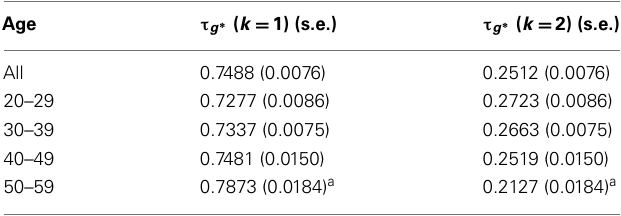
Table 3 | Estimated mixing probabilities for each age